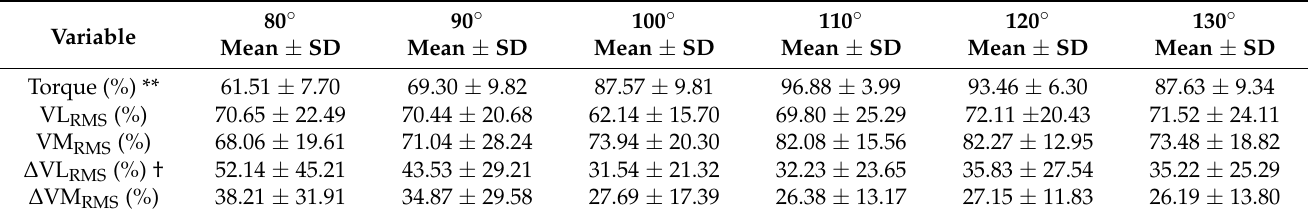
Table 1. Descriptive